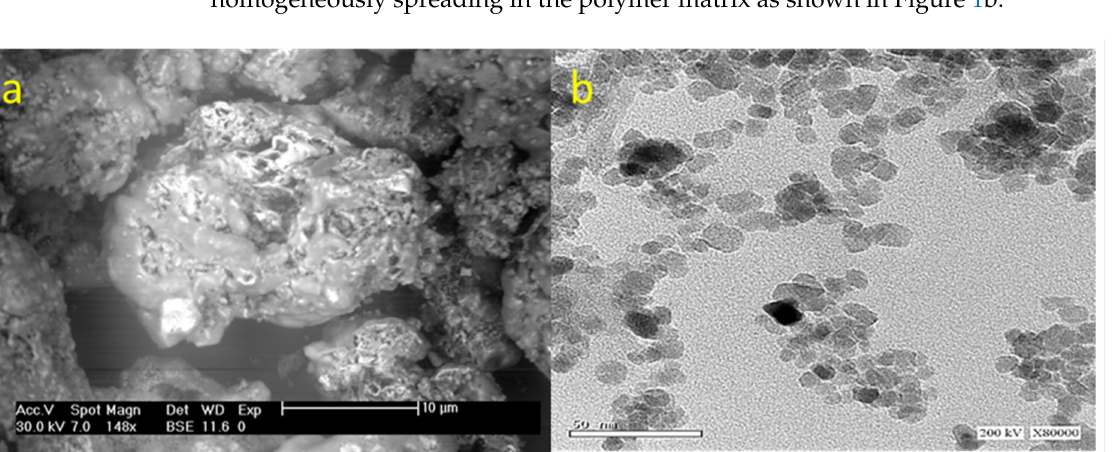
Figure 1. SEM ( a ) and TEM ( b ) analysis of